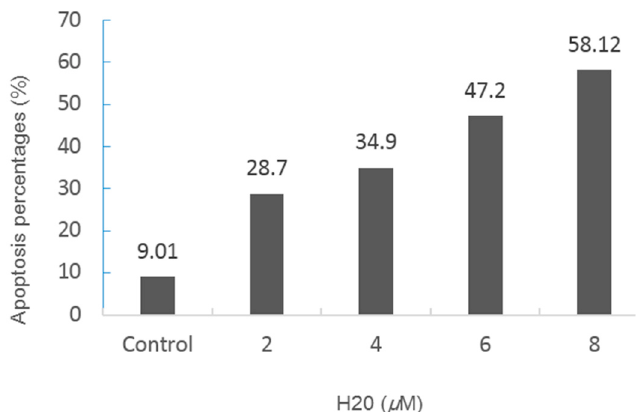
Figure 3. The percentage of early apoptotic cells and late apoptotic cells located in the upper right quadrant. Images were representative of three independent experiments. Values represent the mean ± S.D, n = 3, p < 0.05 versus control.